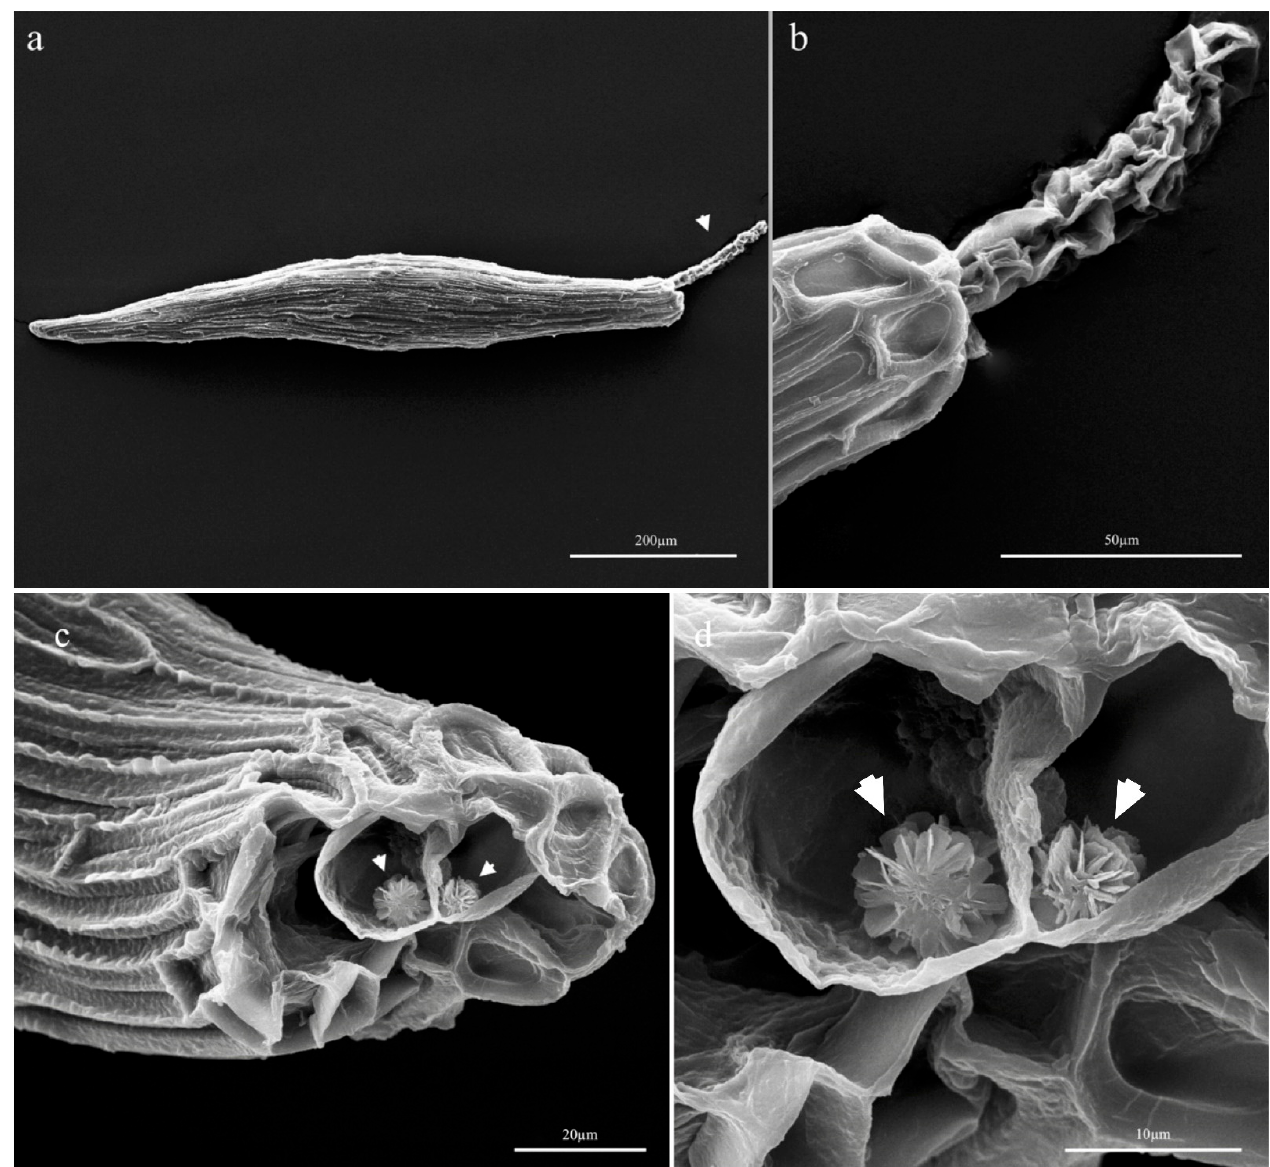
Figure 2. SEM micrograph of Cattleya purpurata seed. ( a ) overview of the seed showing the suspensor (arrow); ( b ) detailed view of the suspensor made of a 2–3 cells-thick layer; ( c ) cutaway of the suspensor highlighting the presence of druses (arrows) inside each cell. At higher magnification, the verrucose microrelief and the granular ornamentation of the seed coat cells are also visible; ( d ) particular of the druses (arrows).